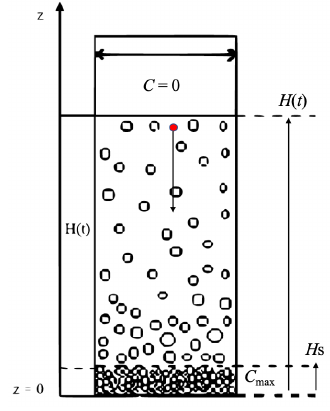
Figure 1. Schematic of the model used to describe sedimentation profiles.